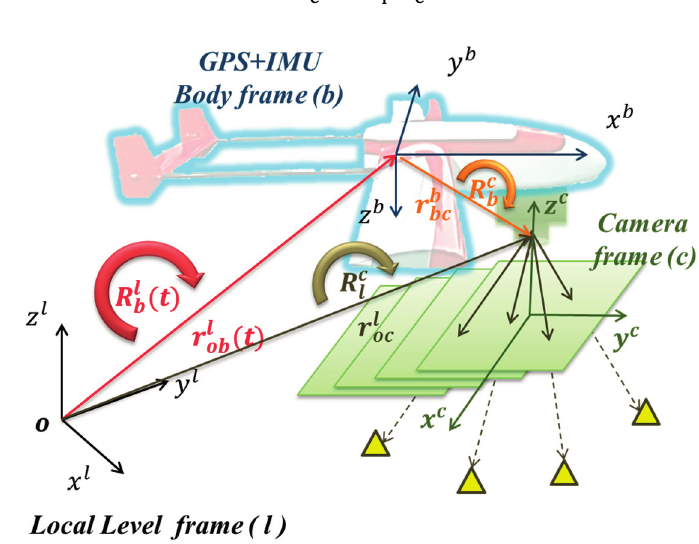
Figure 4. Concept of boresight angle